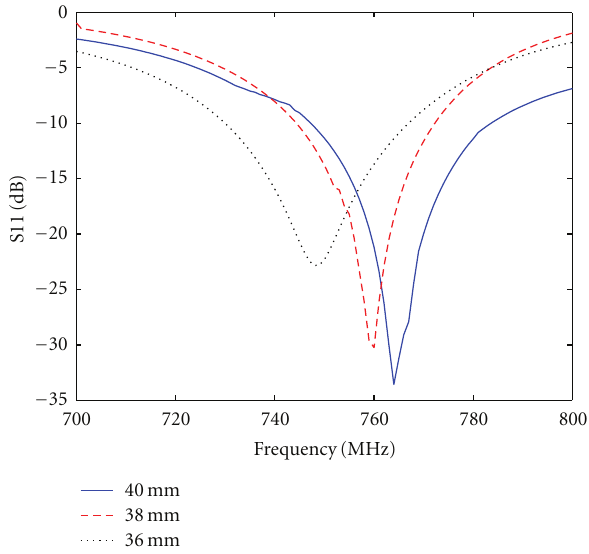
Figure 10: S11 of the antenna with di ff erent L strip .